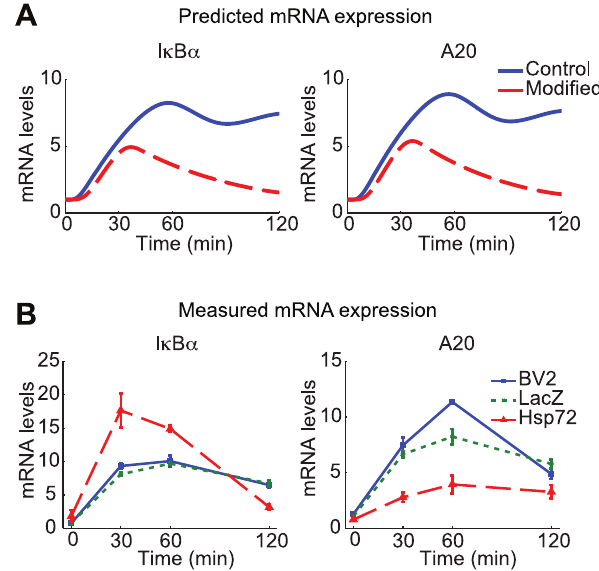
Figure 6. Hsp72 overexpression differentially regulates I k B a transcription. A. Model simulations with the nominal parameters predict that A20 and I k B a mRNA are similarly induced (blue solid lines). The model with modified parameters ( kiA20 set to 10-fold the nominal value, kc2a 1/6 the nominal value, and initial p65 70% of the nominal value) was simulated to find the transcript levels assuming that Hsp72 regulates the network by reducing total p65 and by inhibiting both upstream IKK activation and I k B a phosphorylation (red dashed lines). mRNA levels for I k B a and A20 transcripts are normalized with respect to their initial levels. B. I k B a and A20 mRNA transcript levels (fold change) in all three cell types were measured using qPCR at the indicated times following TNF a addition. I k B a and A20 transcripts are expressed similarly in BV2 and LacZ cells, while relative A20 is decreased in Hsp72 cells. Mean levels in Hsp72 cells are significantly different (P , 0.05) from both BV2 and LacZ cells determined by ANOVA and Newman-Keuls post hoc tests at 30, 60 and 120 min